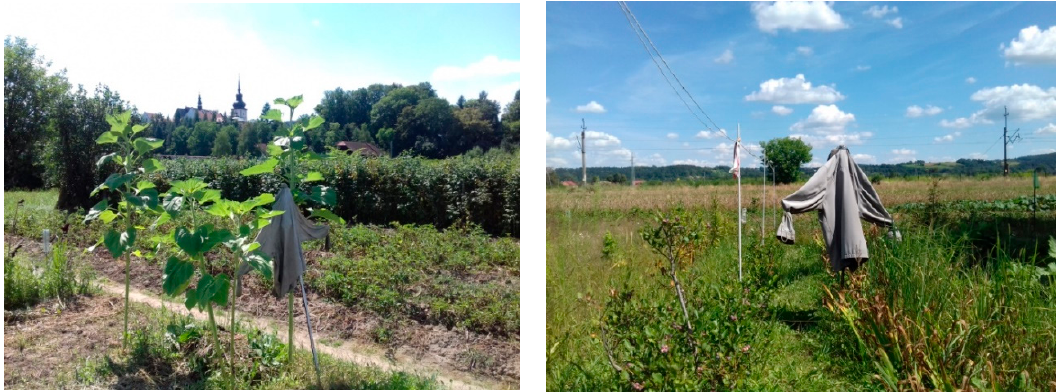
Figure 5. Scarecrows in a vegetable patch. Suburban farming. Near Stary S ą cz (Ma ł opolskie